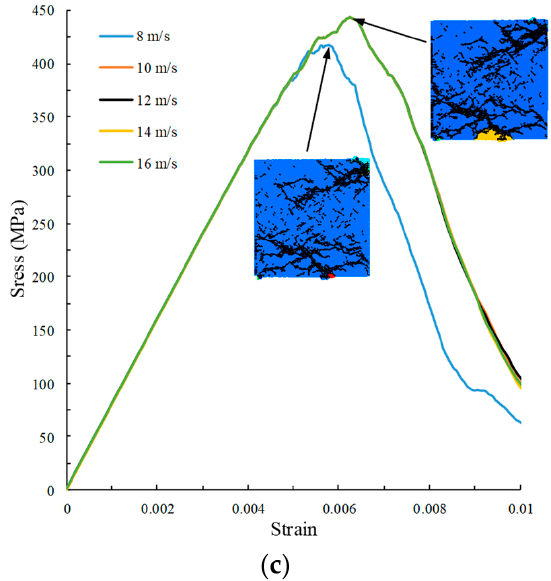
Figure 6. Calculation curve under different amplitudes. ( a ) Time history curves of incident stress wave; ( b ) time history curves of strain rate and stress; ( c ) stress–strain curve.